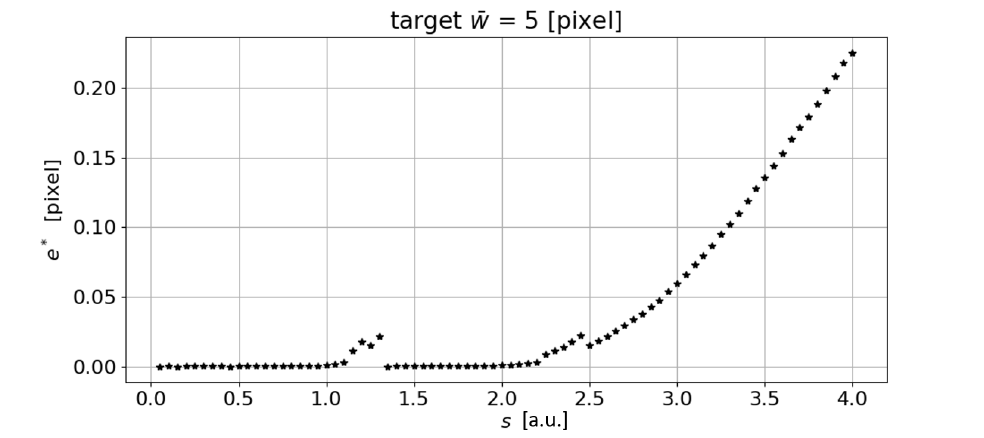
Figure 11. Error e ∗ trend as the parameter s increases (a.u.: arbitrary